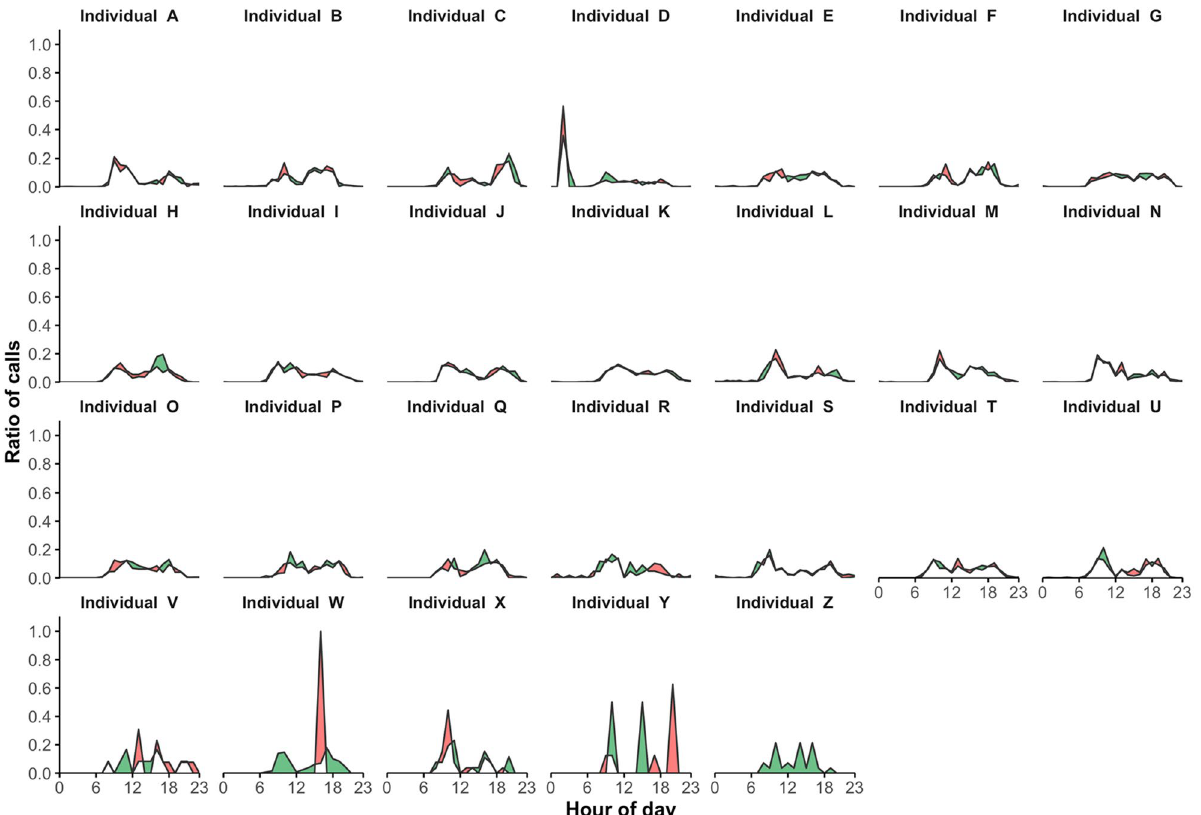
Figure 2. Comparison of two daily rhythms of outgoing telephone call activity. Daily rhythms of outgoing telephone call activity are calculated for the two successive time periods of 6 months each, T 1 and T 2 . Their differences are illustrated by coloring the area between the two corresponding curves: (1) in green when the ratio of calls corresponding to T 1 is higher than T 2 , and (2) in red for the